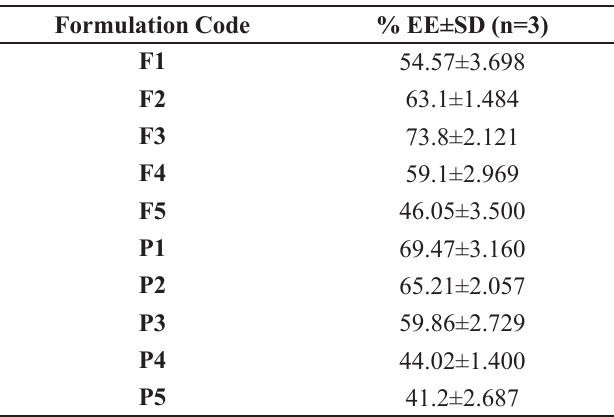
TABLE II - Characterization of the prepared SLNs Formulation